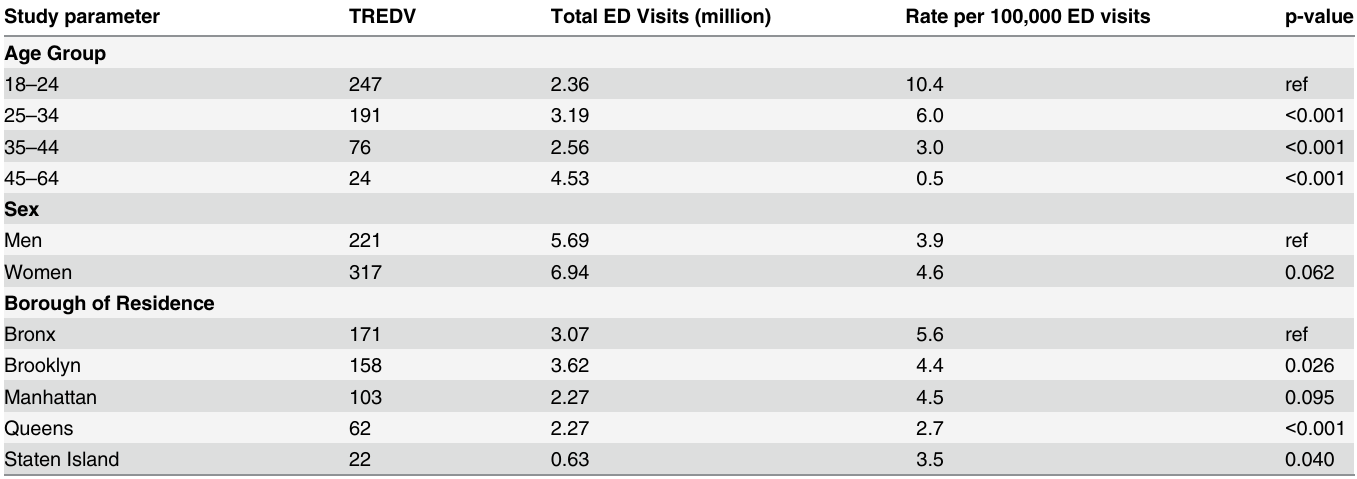
Table 2. Rates of tattoo-related emergency department visits (TREDV) per total adult emergency department (ED) visits by age, sex, and borough of residence, New York City, 2008 – 2012. Study